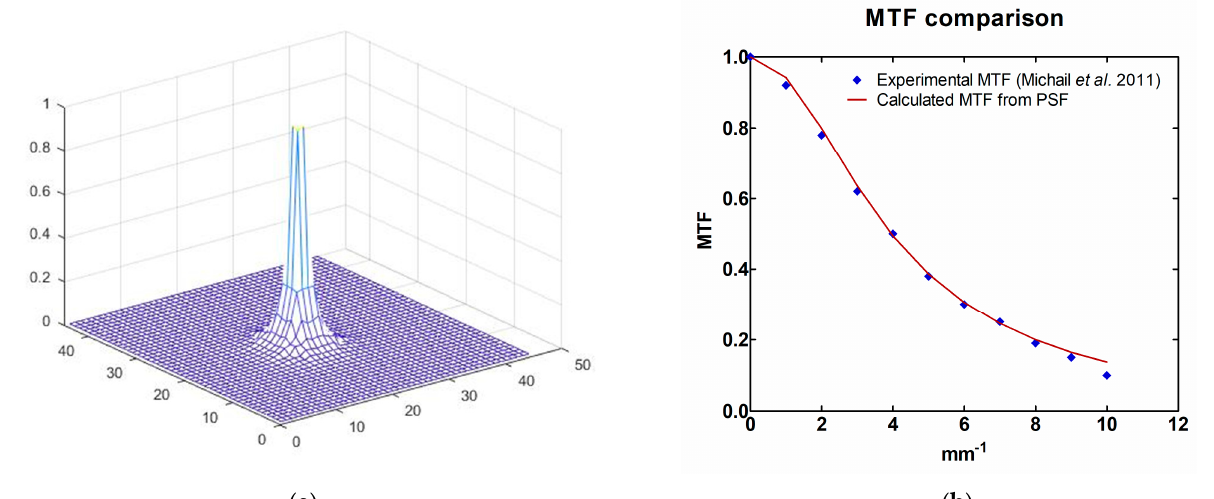
Figure 4. ( a ) PSF derived by rotating Equation (6), and ( b ) published experimental MTF results and the ones theoretically calculated by the PSF of this work [27,30]. (Reference 30 is licensed under CC BY-NC-SA 4.0)